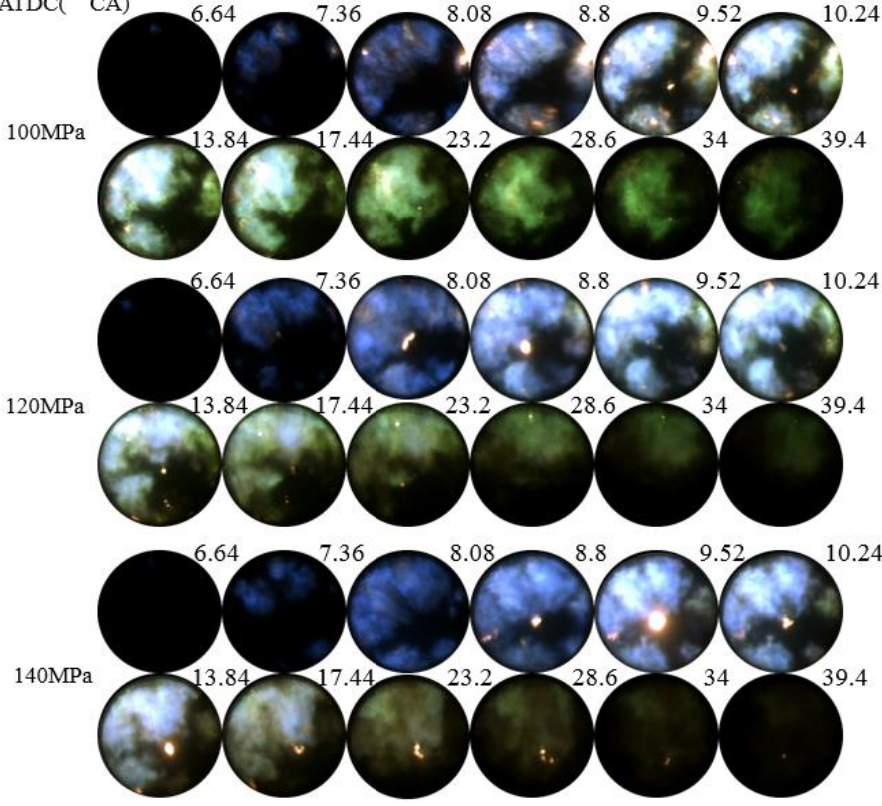
Figure 9. The combustion images of P20 at 6-°CA BTDC injection timing.